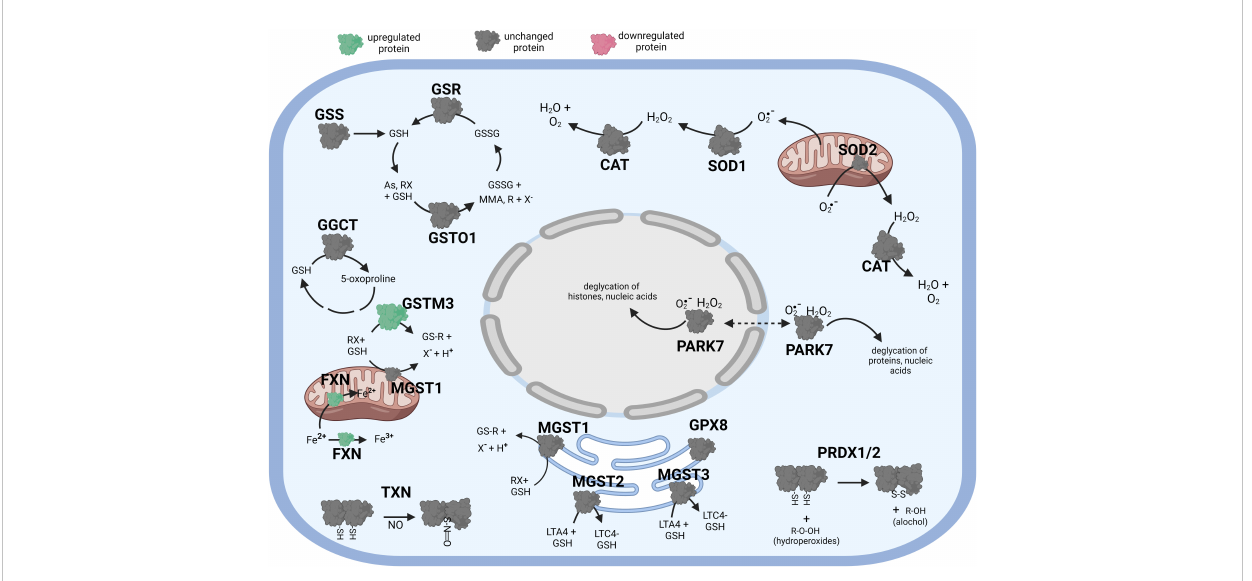
FIGURE 5 Diagramatic summary of the effect of g T pretreatment-tBHP post-treatement versus tBHP treatment alone on antioxidant protein expression. The antioxidant proteins focused on in this study are either upregulated (green), downreuglated (red) or unaffected (no change in expression) (grey) by exposure to a T. The arrows indicate athe direction of a chemical reaction. Exposure of hTERT RPE cells to g T followed by tBHP led to much fewer upregulated antioxidant proteins compare to tBHP or g T alone, but there was an increase in GSTM3 and FXN. Figure created with